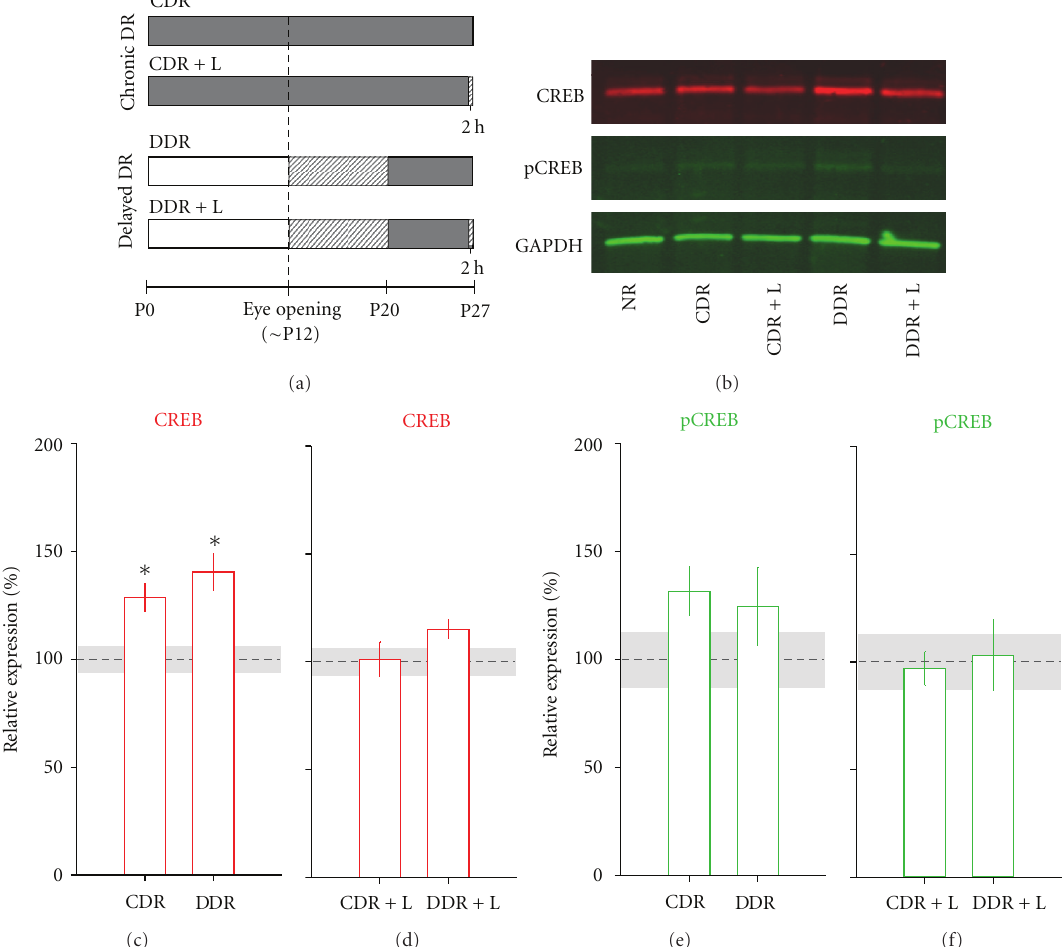
Figure 1: Dark rearing (DR) upregulates total CREB levels in the mouse dLGN. (a) Schematic showing the di ff erent DR conditions. The timeline depicts postnatal age in relation to the periods of DR (dark gray) and patterned visual experience (light gray). CDR and DDR; chronic and delayed DR; CDR + L and DDR + L; chronic and delayed DR followed by 2 hours of normal visual experience. Dotted line indicates the time of natural eye opening. For all conditions, tissue was harvested at postnatal day (P) 27. (b) Representative fluorescent immunoblot showing CREB (red) and pCREB (green) protein levels. GAPDH (green) was used as a loading control. CREB levels were higher in CDR and DDR compared to age-matched controls (normal-light reared, NR), and levels were restored after 2 hours of visual experience (CDR + L and DDR + L). pCREB levels were low and barely detectable (see the Results section for details). ((c)–(f)) Quantification of immunoblots ( n = 5) for CREB ((c) and (d)) and pCREB ((e) and (f)) levels for DR ((c) and (e)) and DR + L conditions ((d) and (f)). The bars depict the relative averaged optical densities for each of the DR conditions ( n = 6–8 dLGNs for each group per blot). Error bars represent ± SEM. The dotted line and corresponding shaded area reflect the averaged and ± SEM of CREB or pCREB protein levels obtained from age- matched controls. Total CREB levels for both DR conditions were significantly higher than control ((c), LSD post hoc test, ∗ P < 0 . 05 for both